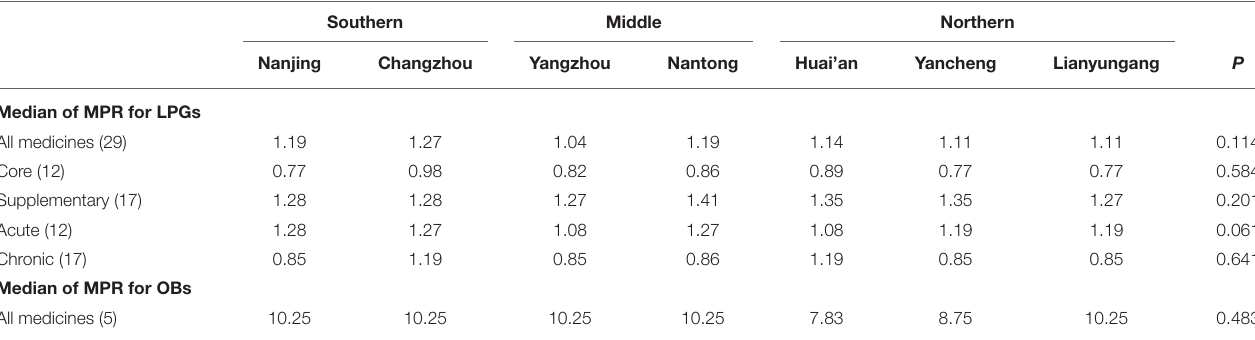
TABLE 6 | Median MPR of essential medicines in seven